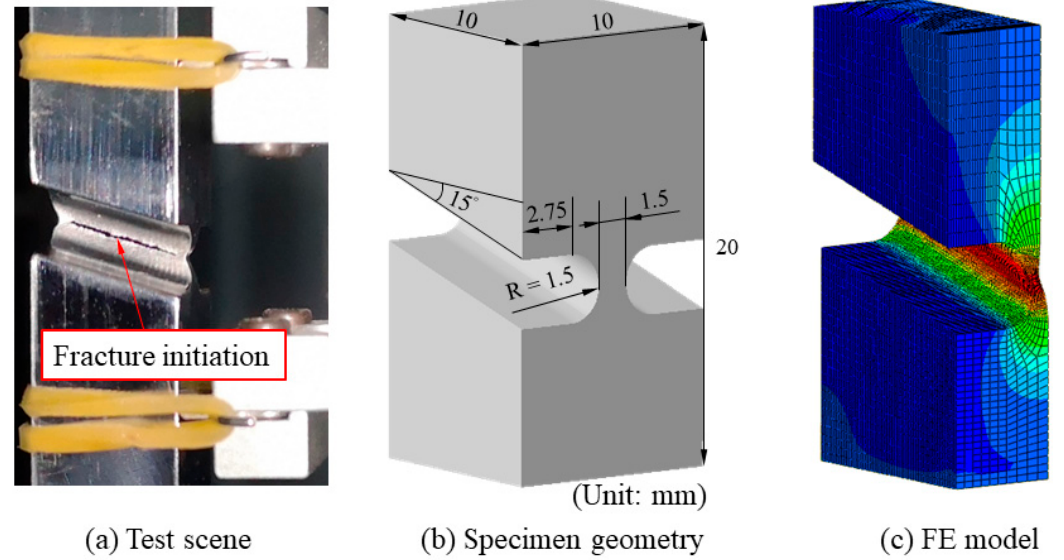
Figure 12. Illustration of X80 pipeline steel specimen.